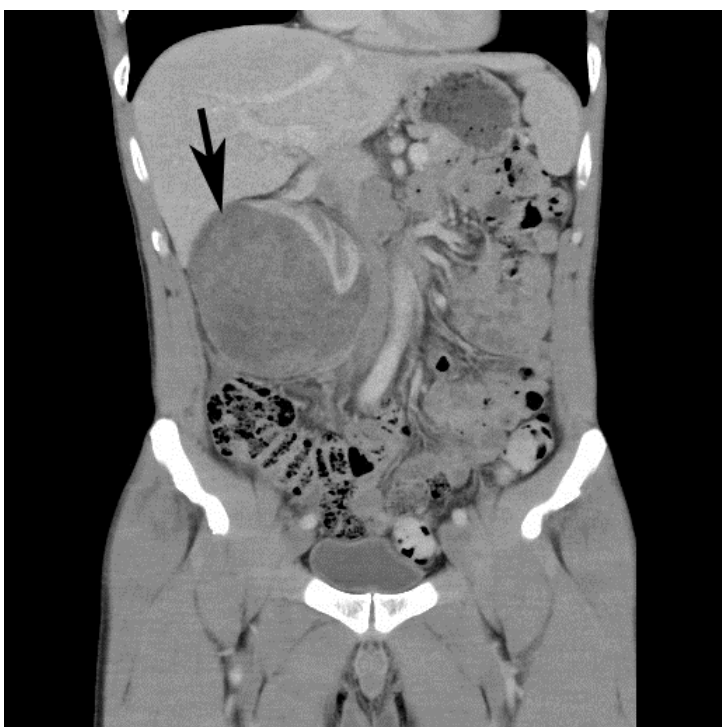
Figure 1. CT scan – coronal view. Large mass lesion (arrow) within right kidney measuring up to 7.4 × 7.5 × 9.2 cm.